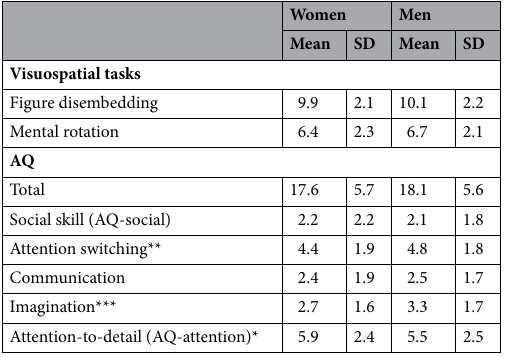
Table 1. Scores (mean and SD) on visuospatial tasks and AQ, separately for women and men. N = 206 women, 220 men; * p = 0.044; ** p = 0.029; *** p = 0.0001.